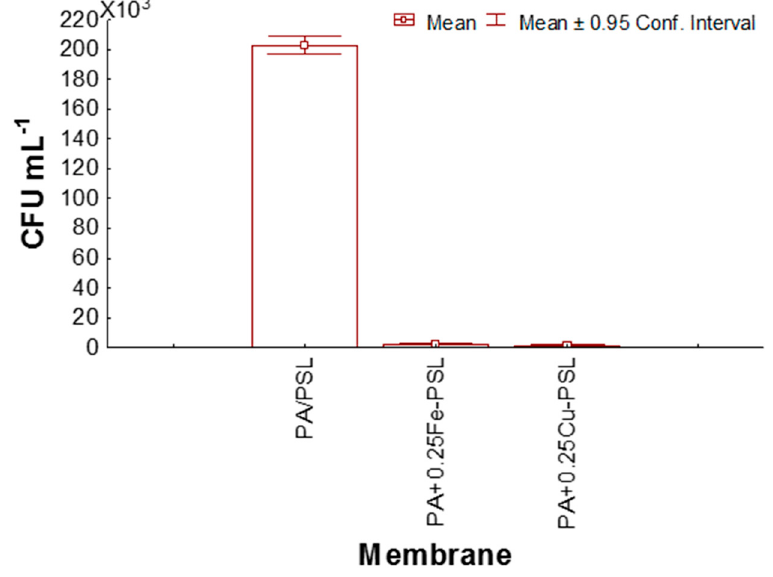
Figure 6. Bactericidal effect of the membranes on E. coli.